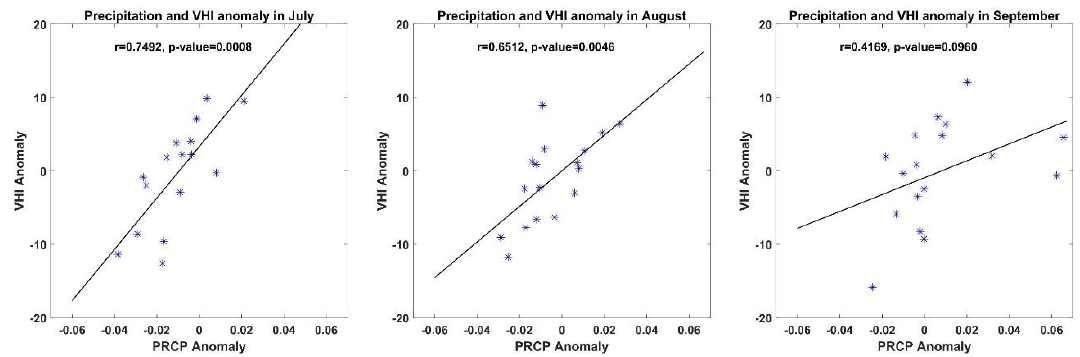
Figure 10 . Monthly VHI anomalies showing a strong correlation with rainfall anomalies in July, August, and September, the major crop growth season in the